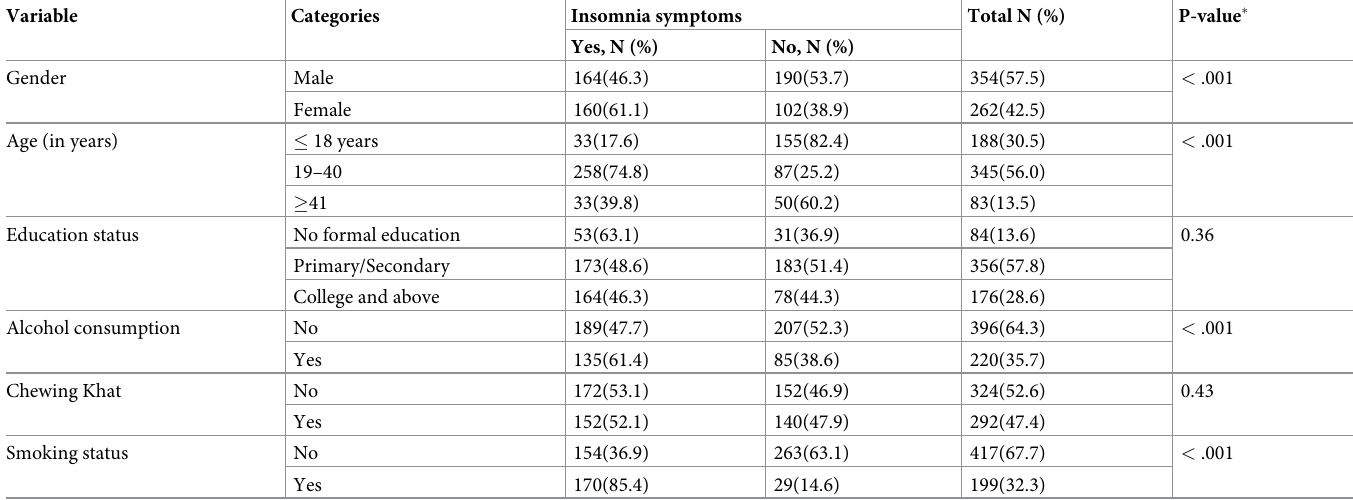
Table 1. Demographic profile of respondents and insomnia symptoms.